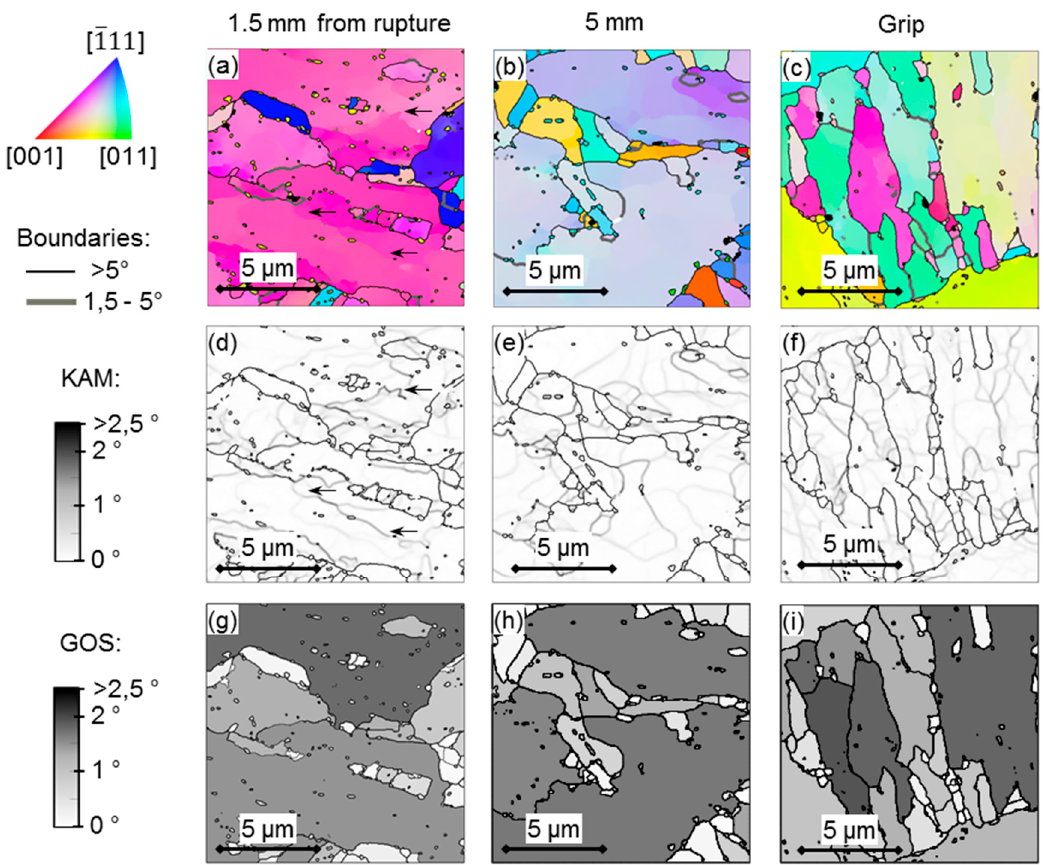
Figure 11. ( a – c ) IPF maps showing crystal orientations relative to the sample normal according to the colour key (top left), ( d – f ) KAM maps, and ( g – i ) GOS maps of areas at 0 mm and 5 mm from the maximum temperature gauge region and at the grip of the EXH material.